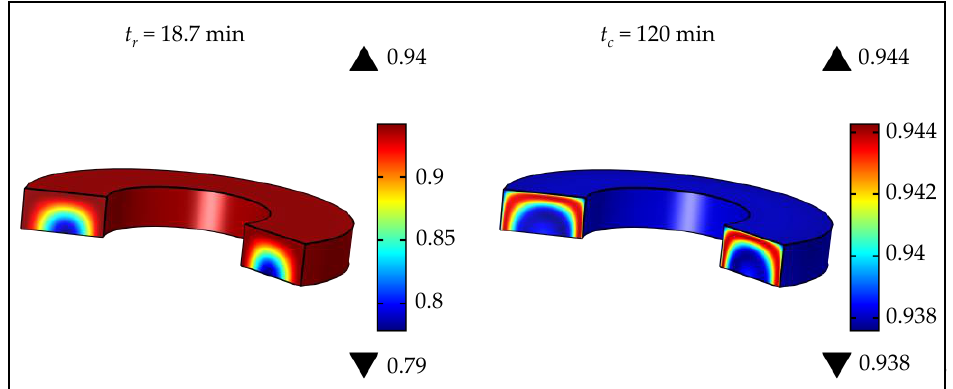
Figure 12. Vulcanization simulation of Product 1 at t r and t c , at optimal temperature ( T M = 155 °C).